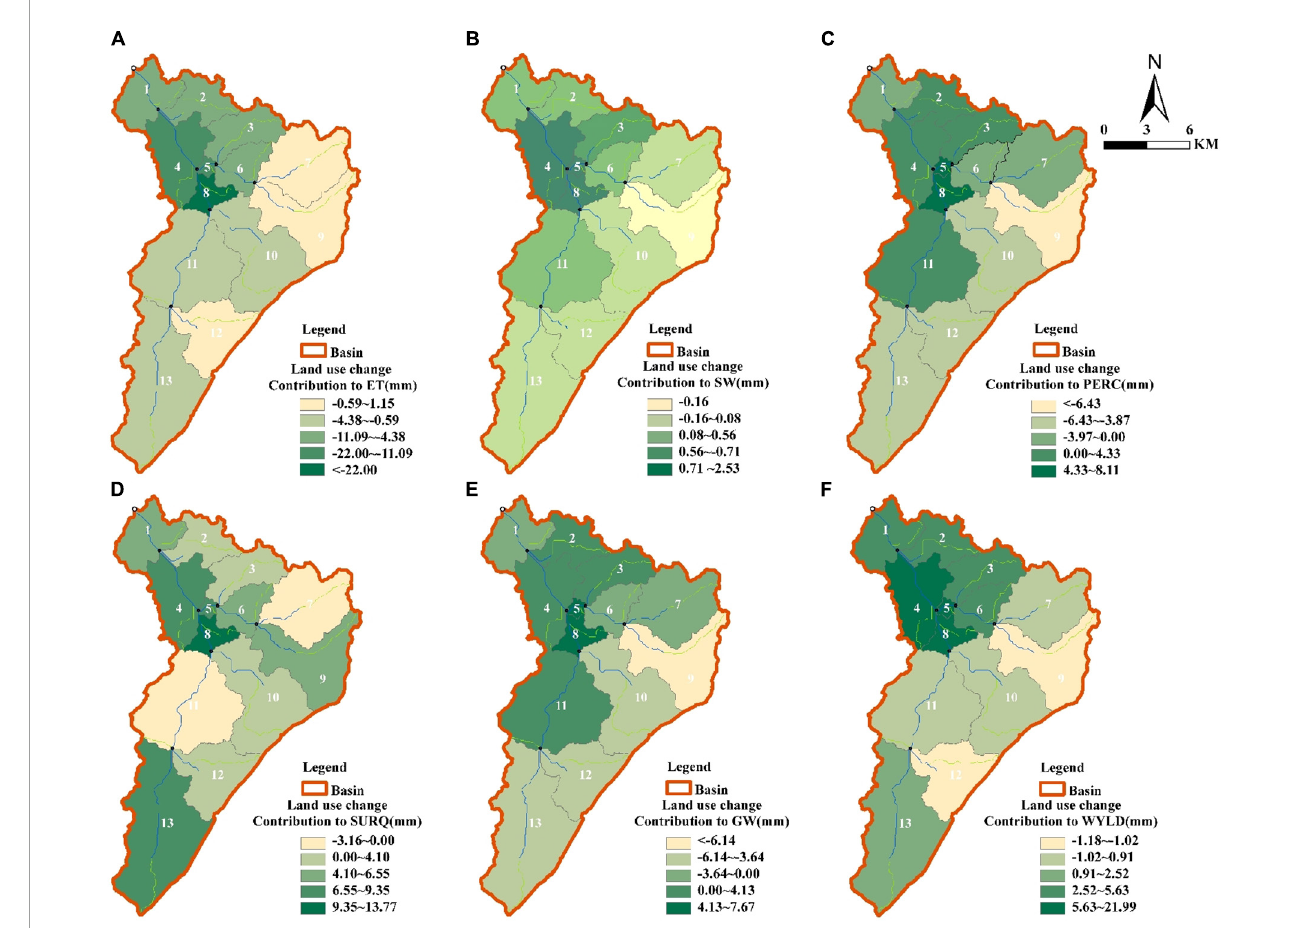
FIGURE11 Response intensity distribution of key hydrological components to land use change at subbasin scale. (A) Evapotranspiration; (B) soil water; (C) infiltration; (D) surface runoff; (E) Underground runoff; (F) water yield.